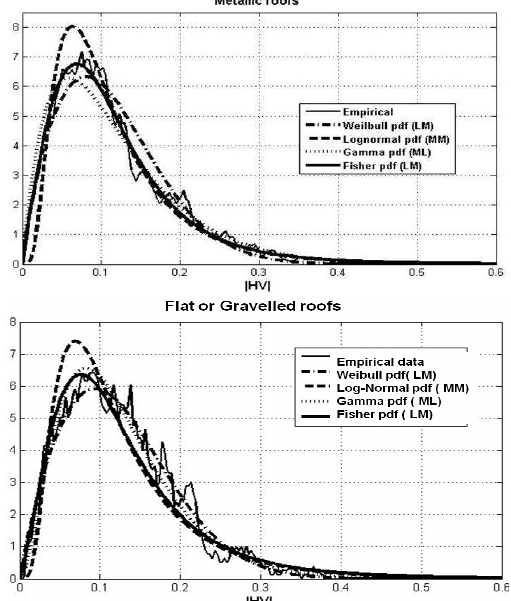
Figure 2. Empirical |HV|-histograms and pdfs estimated using ML or MoM for two